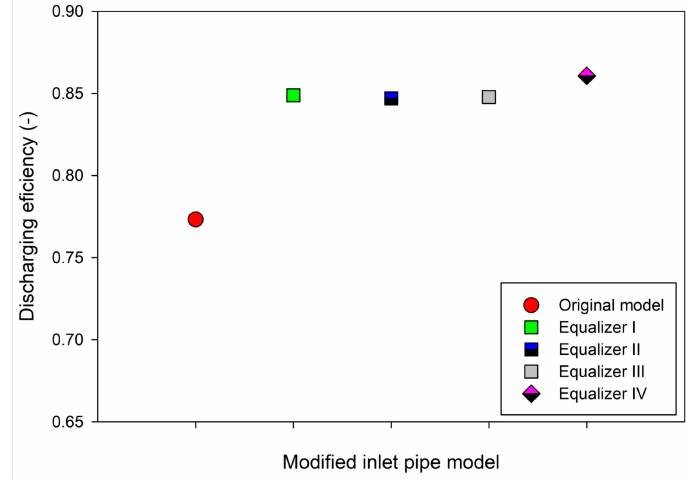
Figure 17. The discharging efficiencies of the equalizer models.